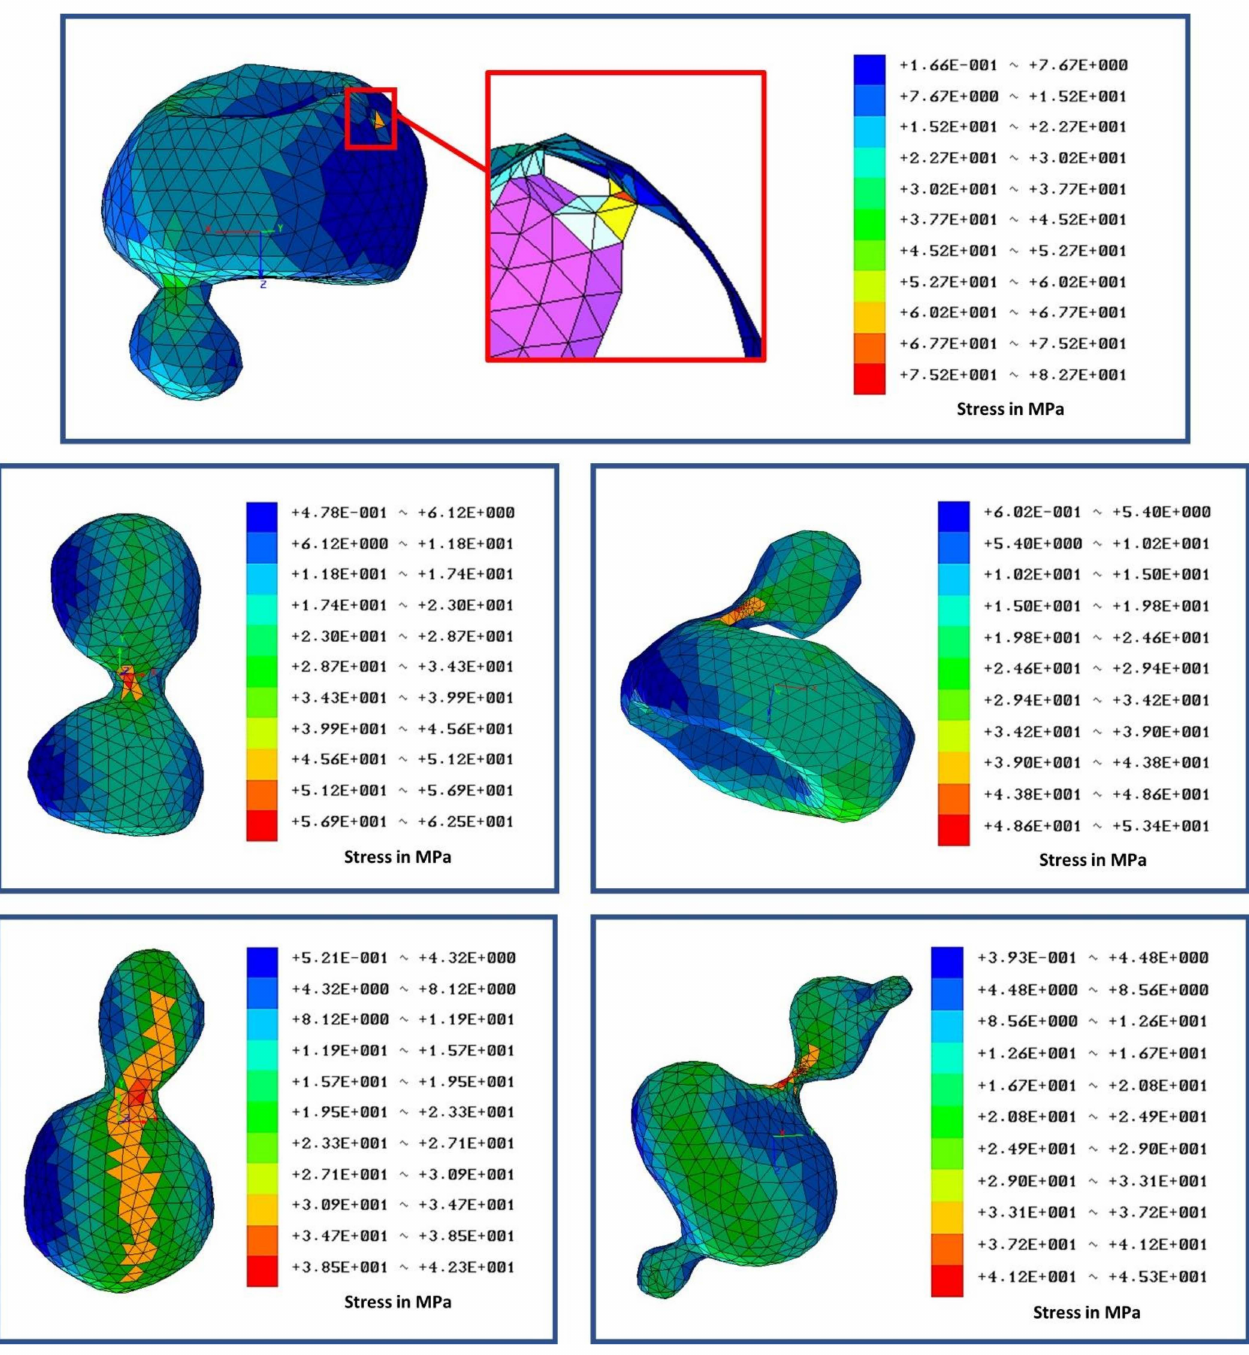
Figure 10. FE analysis of the most critical pore shapes relating to stress concentrations. Each pore was loaded vertically or horizontally related to the plane of the largest projected area. The FEA results with the highest stress concentrations are